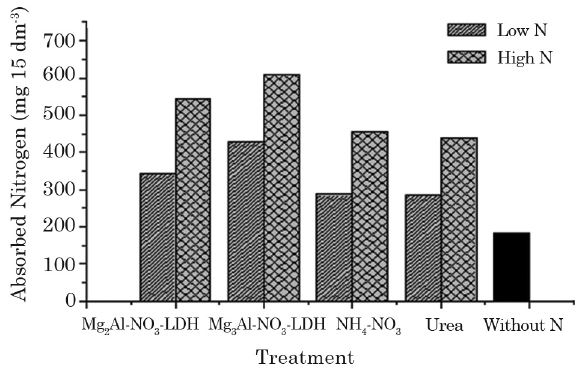
Figure 9. Absorbed nitrogen by successive crops of radish, lettuce and sorghum influenced by N sources and doses (low N: 40 mg dm -3 and high N: 100 mg dm -3